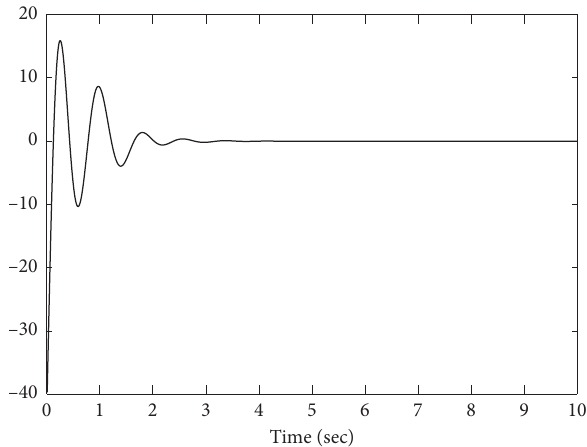
Figure 4: The trajectory of the output feedback controller.